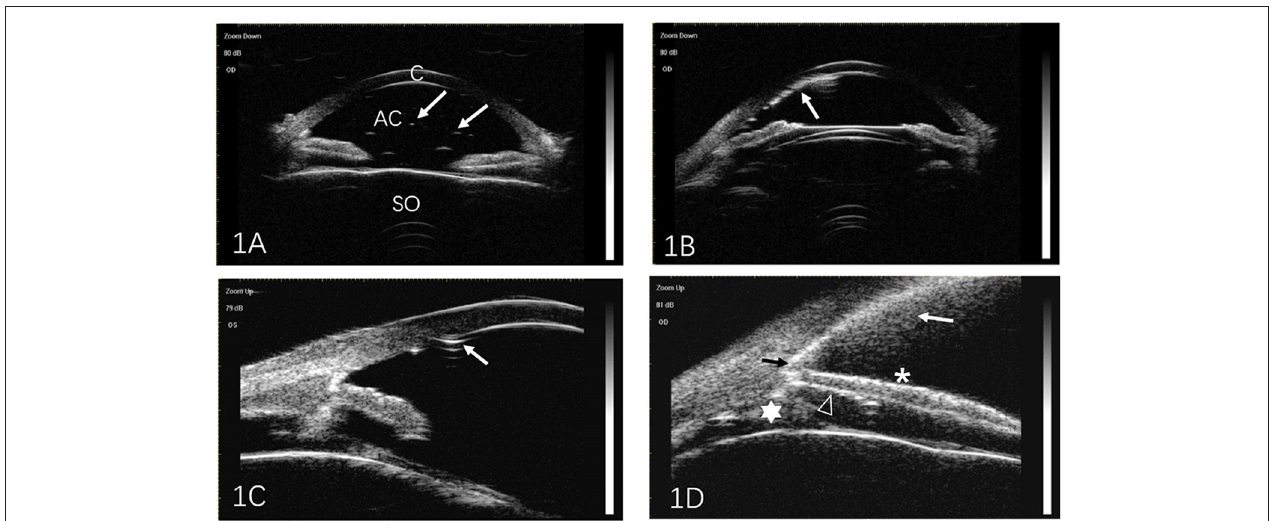
FIGURE 1 | Representative ultrasound biomicroscopic images of silicone oil (SO) emulsification. (A) Individual SO particles floating in the anterior chamber (arrows). (B) SO particles adjacent to the cornea (arrow). (C) Ghost images. Multiple echoes from SO particles adjacent to the corneal endothelium may be seen as needle-shaped artifacts hanging from the endothelium (arrow). (D) Hyperoleon. A massive collection of emulsified SO particles (white arrow), and impregnation of the anterior chamber angle (black arrow), anterior surface of the iris (asterisk), posterior surface of the iris (triangle), and ciliary body (star). C, cornea; AC, anterior chamber; SO, silicone oil.